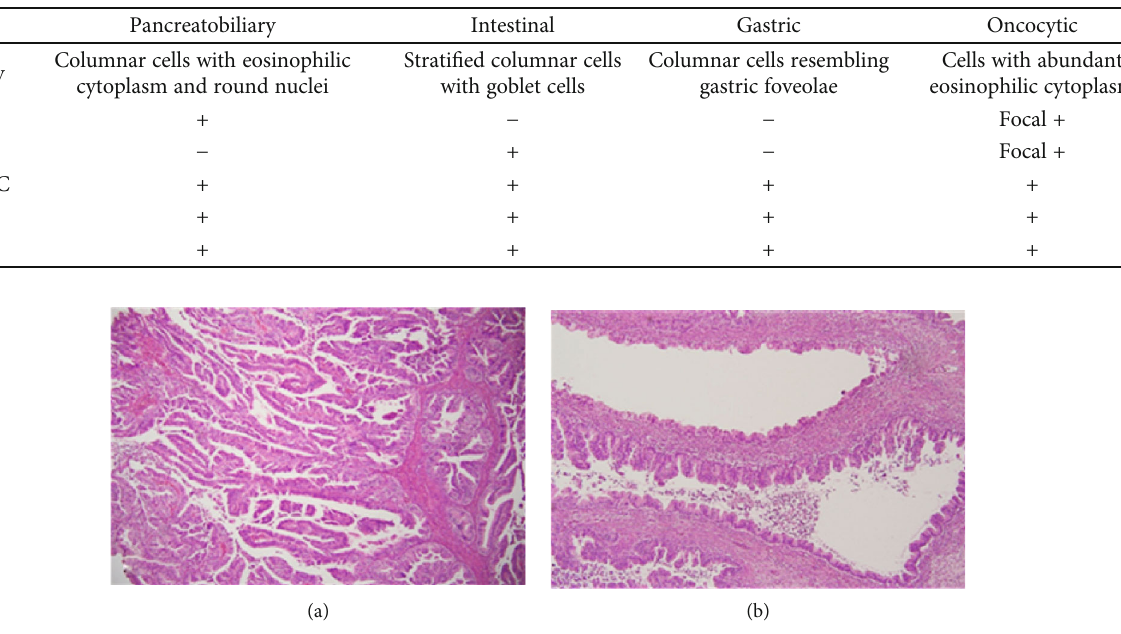
Figure 2: Histology image of biliary cancer precursors. (a) Intraductal papillary neoplasia of the bile duct (IPNB) — bile duct with papillary architecture of the epithelium and cytological nuclear abnormalities. (b) Biliary mucinous cystic neoplasia (BMCN) — cyst with the epithelium of the mucinous type and variable grade of nuclear abnormalities. Haematoxylin-eosin staining (courtesy of Dr. Jana